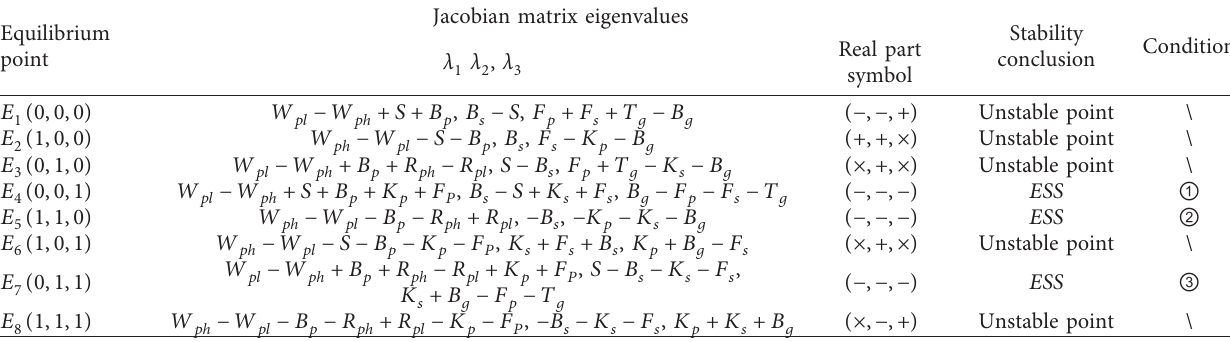
Table 2: Stability analysis of the system equilibrium